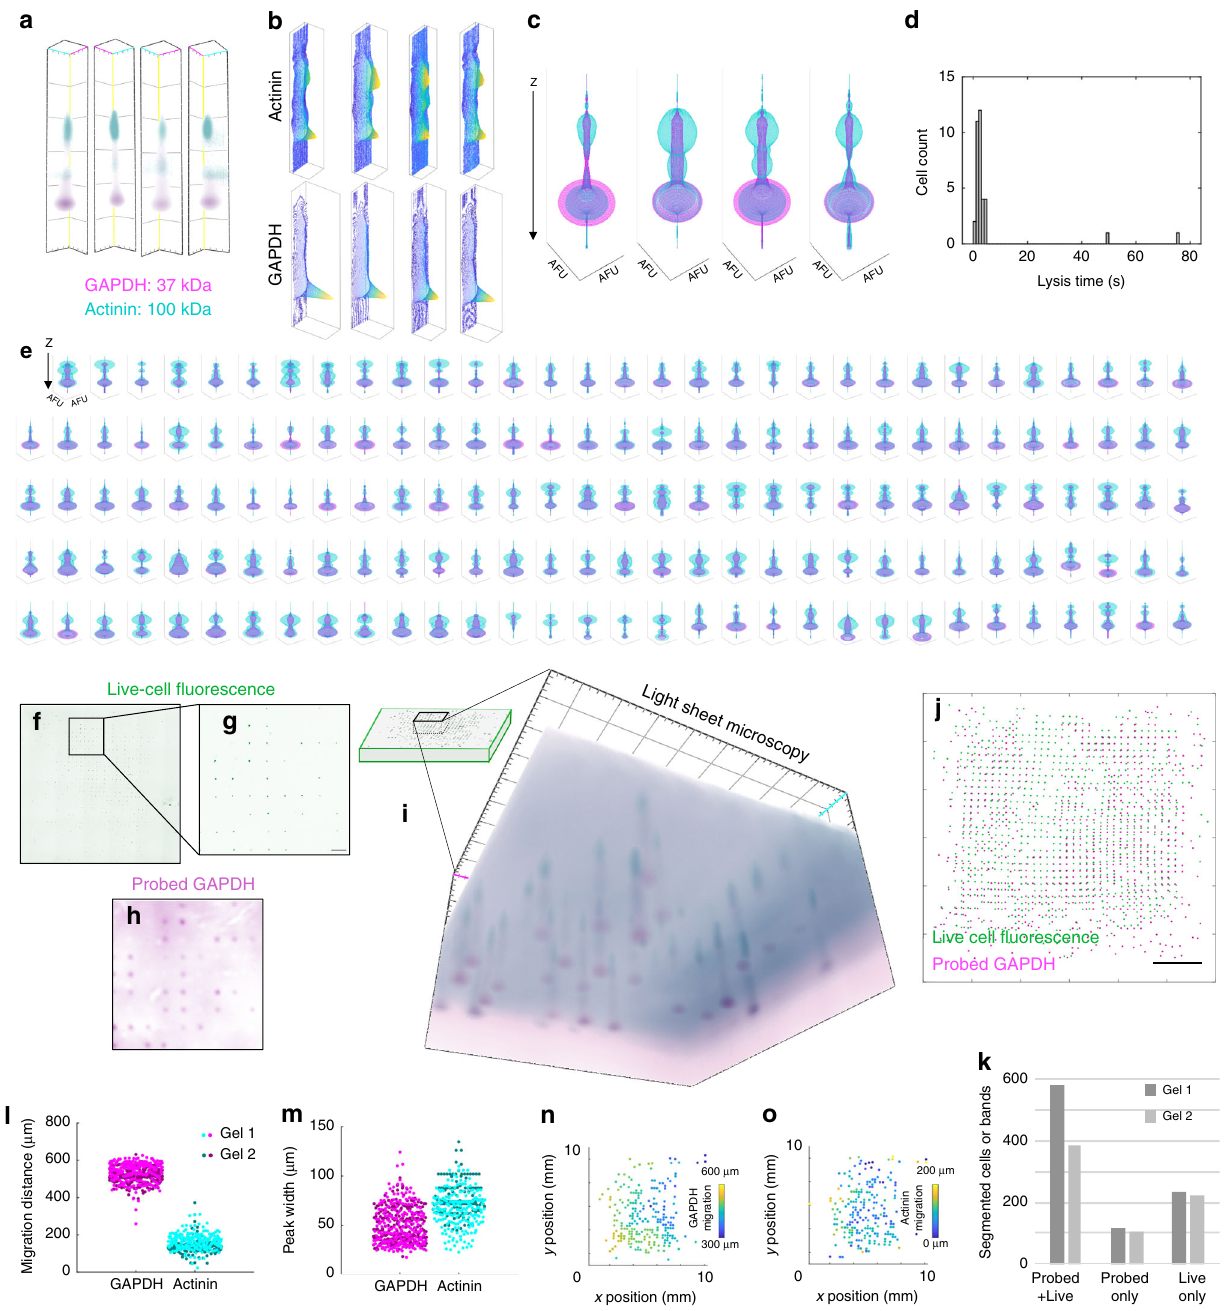
between the channels (optical fi lter sets) of the light-sheet